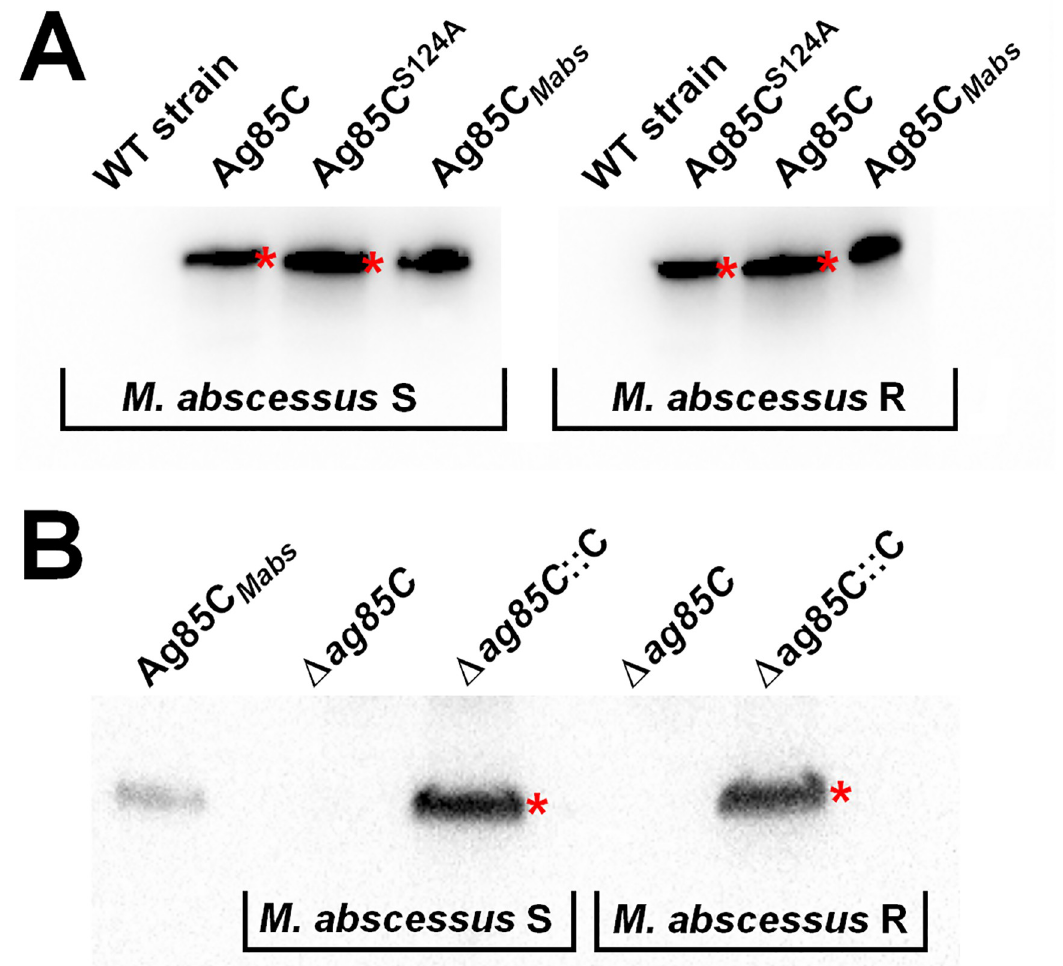
Fig 3. Western blot analysis of M . abscessus -Ag85C-mutant strains: (A) overexpression of active ( i . e .,Ag85C) or inactivated ( i . e ., Ag85C S124A ) protein; (B) deletion ( i . e ., Δ ag85C ) and complementation ( i . e ., Δ ag85C ::C) strains (see S1 Appendix file for cloning details). Each overexpressed protein, indicated with a red star, were revealed using HisProbe ™ HRP conjugate (Thermo- Fisher Scientific) and compared to the M . abscessus wild-type strain (WT) as well as pure recombinant Ag85C control. In each case, equal amount of whole bacterial cell lysate has been loaded for the overexpression strains (panel A ), and for the deletion/complementation strains (panel B ),